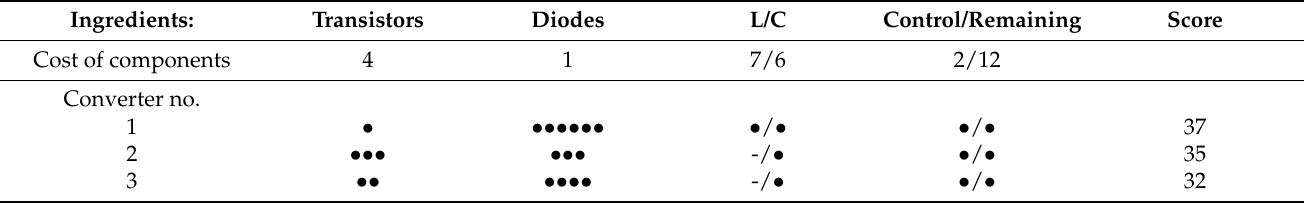
Table 2. Estimated construction costs of the analyzed converters: 1—tree-phase full bridge rectifier with the boost converter; 2—three-switch converter; 3—two-switch converter.